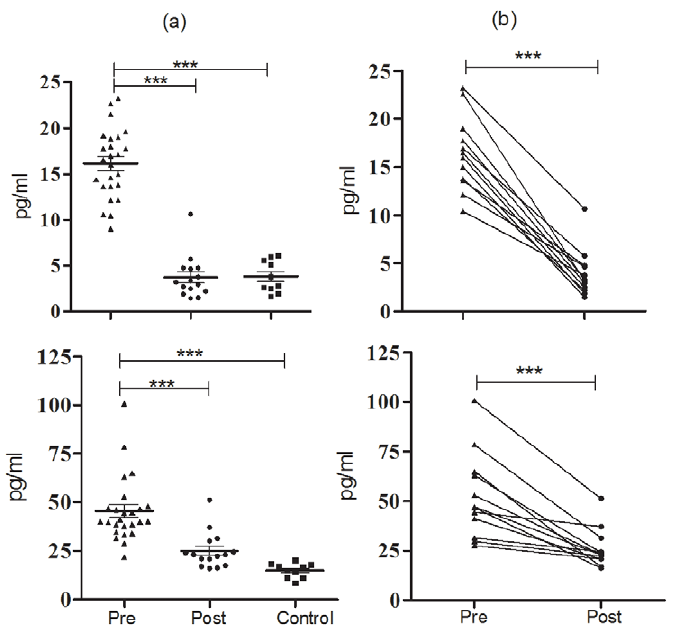
Figure 4. Plasma levels of IL-17 and IL-23 in PKDL. Plasma levels of IL-17 and IL-23 determined by ELISA (a) at pre (n=25), post-treatment stage (n=15), controls (n=10) or (b) in paired samples (n=12) (b). Individual values (pg/ml) are presented and the mean 6 SE are shown. **P , 0.01, and ***P , 0.001.